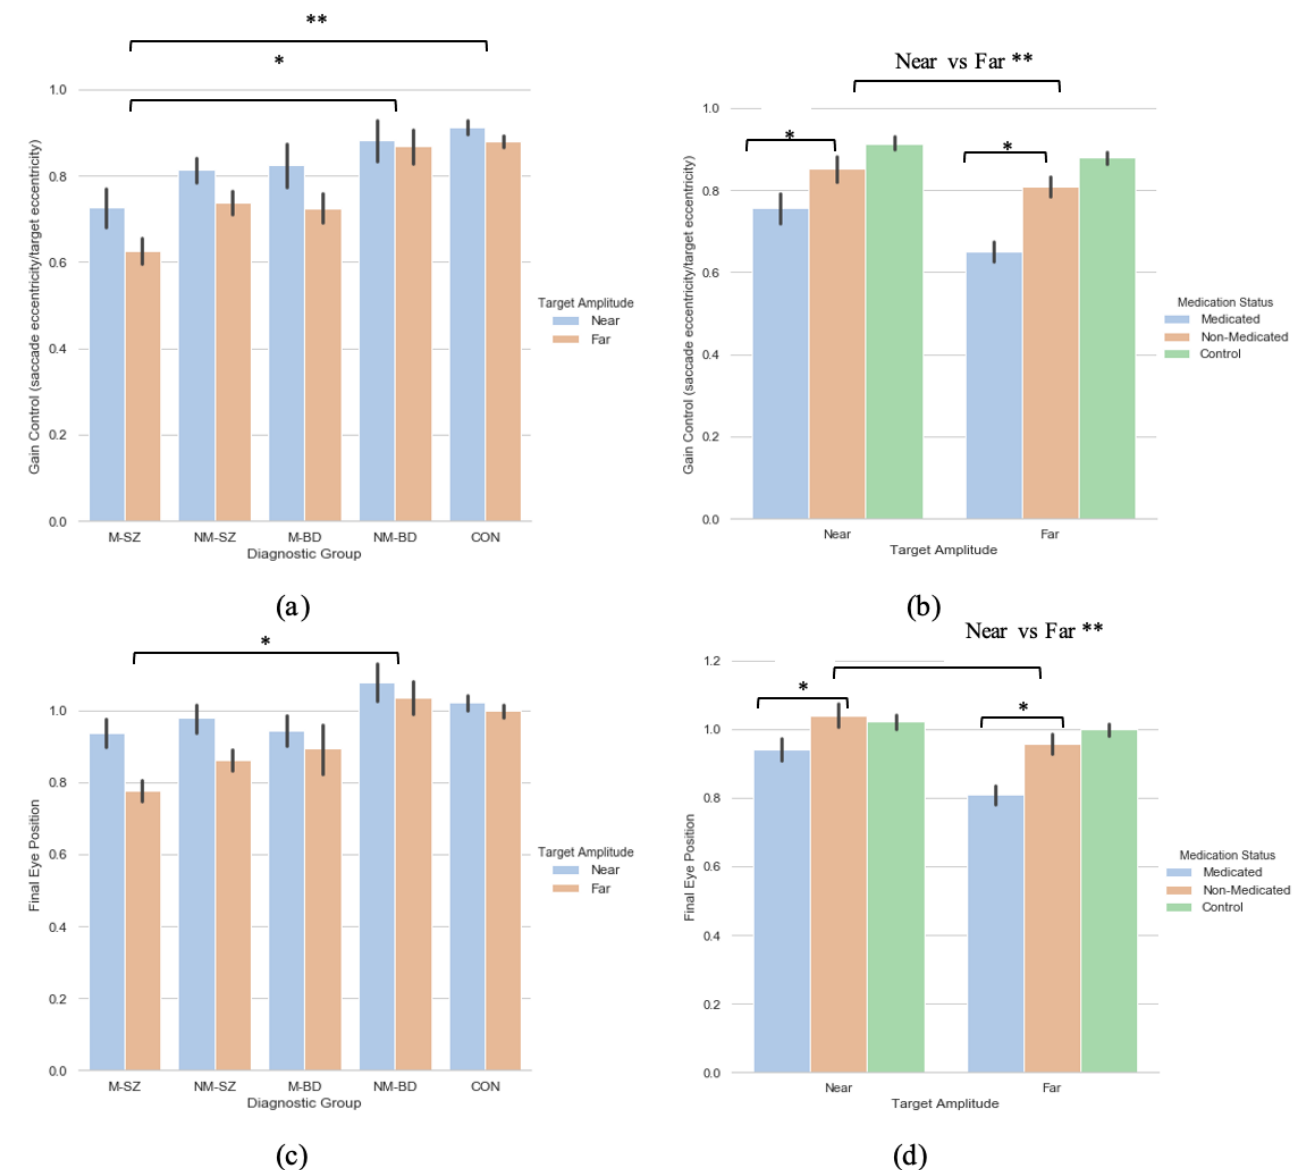
Figure 2. A comparison of performance in the ( a ) gain and ( c ) final eye position measures between the two target eccentricities within each diagnostic group; a comparison of performance in the ( b ) gain and ( d ) final eye position measures between the two peripheries between the medicated and non-medicated cohorts (collapsed across diagnostic category). For reference, the control cohort are included here but were not included in the reported analysis. * Refers to significance at the p < 0.05 level. ** Refers to significance at the p < 0.01 level. Error bars refer to standard error.